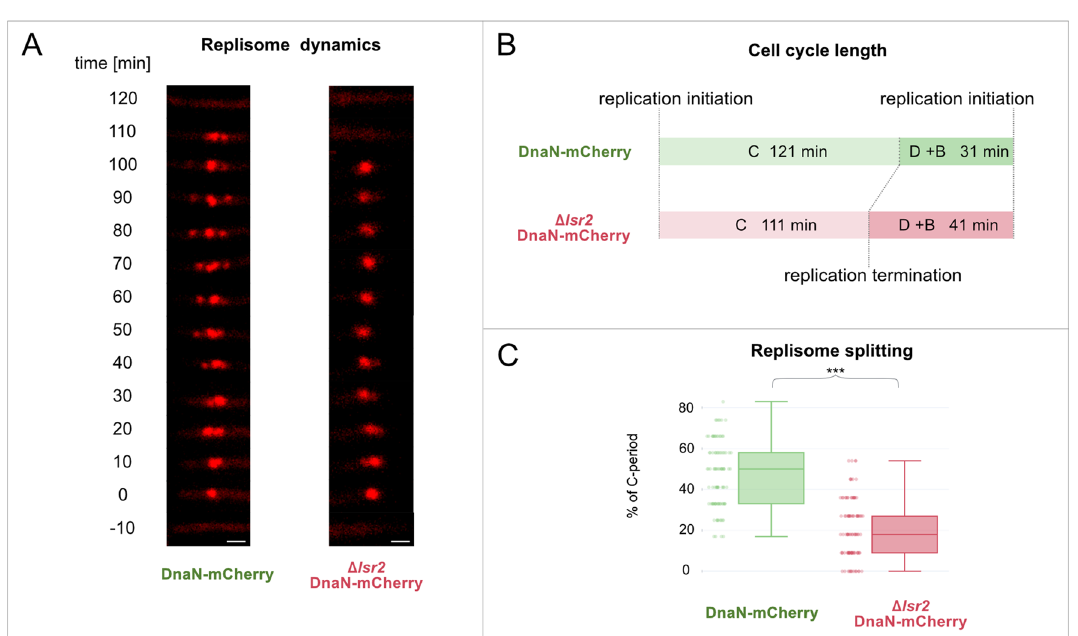
Figure 3. Influence of lsr2 deletion on the cell cycle and replisome dynamics. ( A ) Real-time microscopic analysis of replisome dynamics during one replication event. In WT cells, replisomes frequently divide and merge; in Δ lsr2 , in contrast, the replisomes form one fluorescent focus for most of the C-period. Bar 1 µm. ( B ) Schematic representation of the mycobacterial cell cycle in the WT and lsr2 deletion strains. ( C ) Replisome splitting expressed as the duration when the DnaN-mCherry marked replisomes were observed as more than one fluorescent focus, calculated as a percent of the total replication duration (n = 100, *** p < 0.0005; parametric double-sided t test with pooled